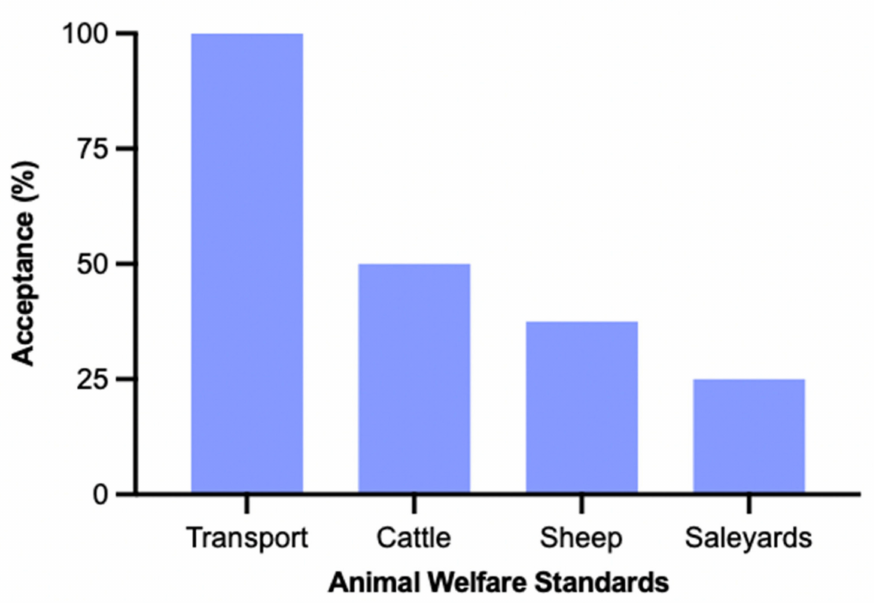
Figure 3. Acceptance rates of the animal welfare standards [20] currently available across the Australian jurisdictions. Acceptance is measured by their incorporation under any legislation (not exclusive to animal welfare legislation), in primary or secondary form. Transport standards have been accepted by all jurisdictions (100%); cattle standards accepted by NSW, QLD, SA, WA (50%); sheep standards accepted by NSW, QLD, SA (37.5%); saleyard and depot standards accepted by QLD, WA